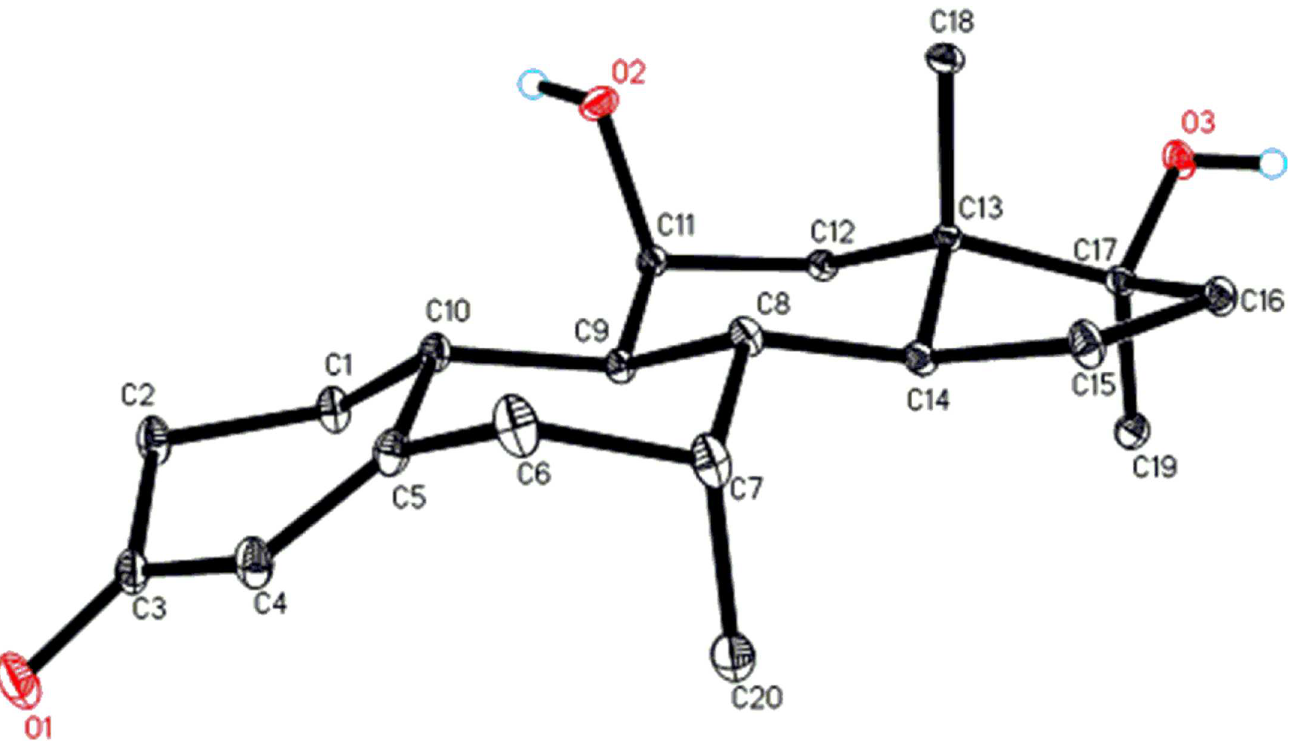
Fig 8. ORTEP drawing of X-ray structure of compound